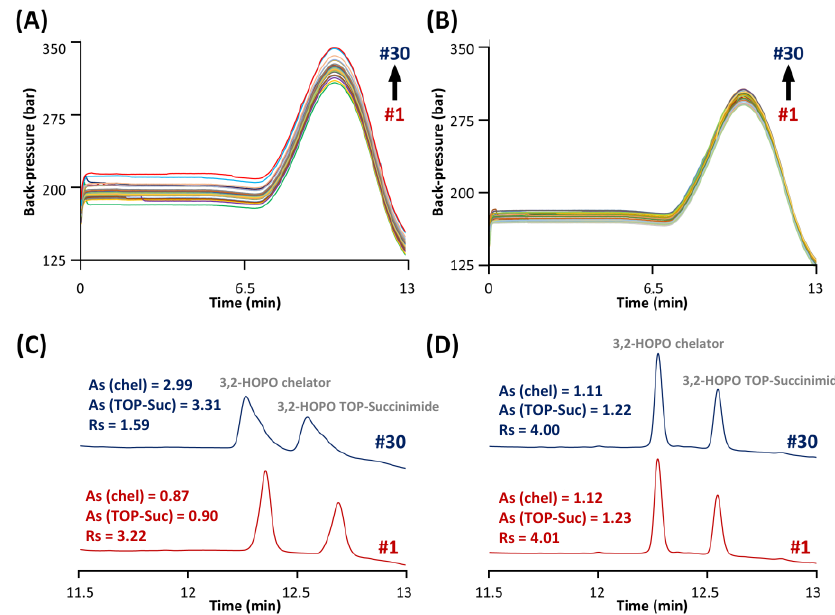
Figure 4. Evolution of the column back-pressure during 30 injections of ACC samples spiked with the synthesis impurities. Samples analyzed ( A ) before and ( B ) after the ACC removal through filtration. Chromatographic behavior of 3,2-HOPO chelator and its by-product TOP-succinimide by comparing the first (red) and 30th (blue) injection of samples analyzed ( C ) before and ( D ) after the ACC